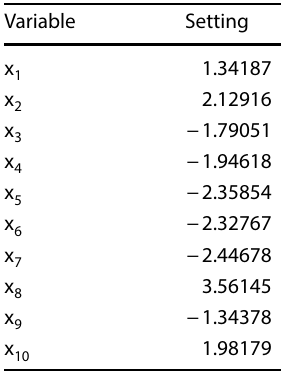
Table 10 Input settings for the first interval